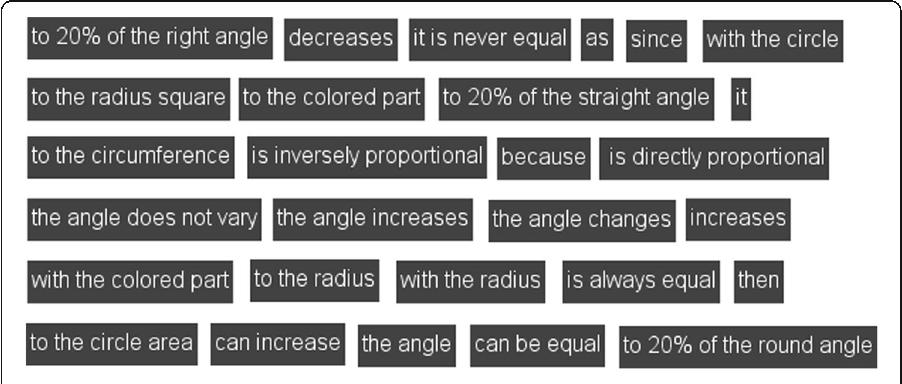
Fig. 1 Language tiles case study in Albano, Dello Iacono, Mariotti